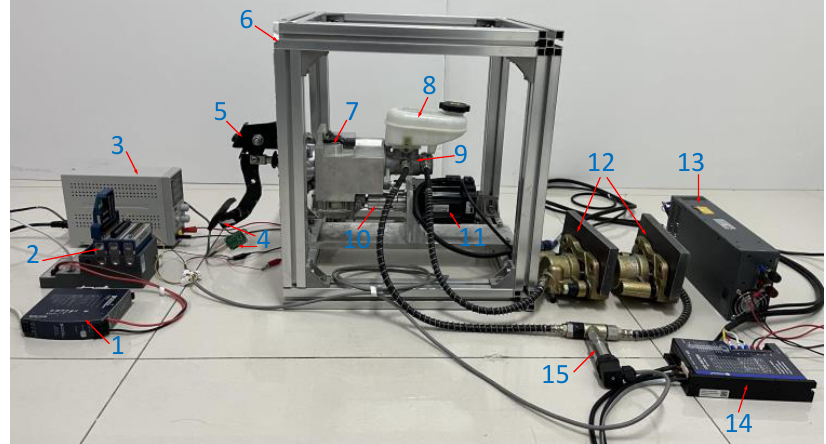
Figure 19. Target oil pressure following control test bench: 1. NI acquisition card chassis, 2. NI acquisition card, 3. DC power supply, 4. WT901CM attitude sensor, 5. brake pedal, 6. test bench bracket, 7. Electric-assisted braking system shell, 8. oil cup, 9. master cylinder, 10. coupling, 11.